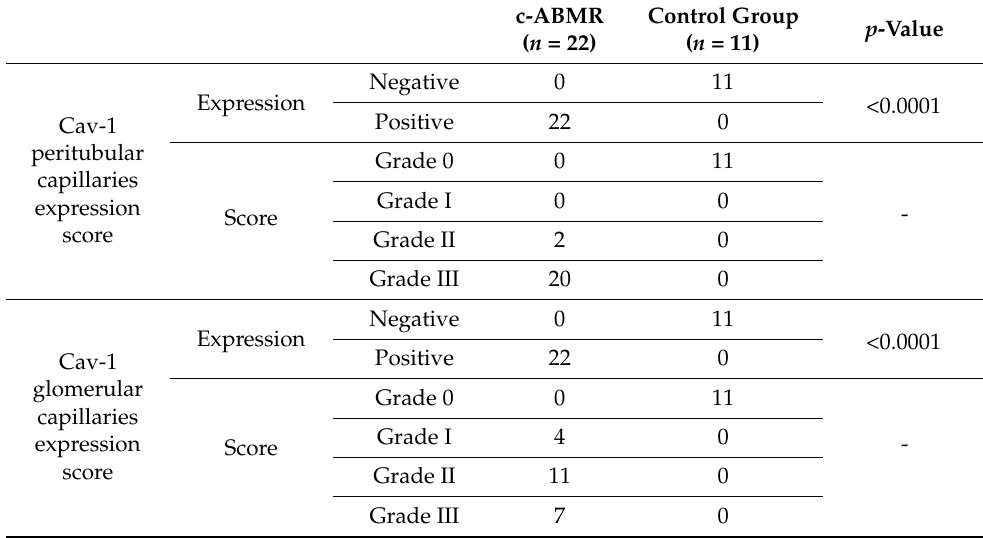
Table 4. Cav-1 IHC score results in c-ABMR and control